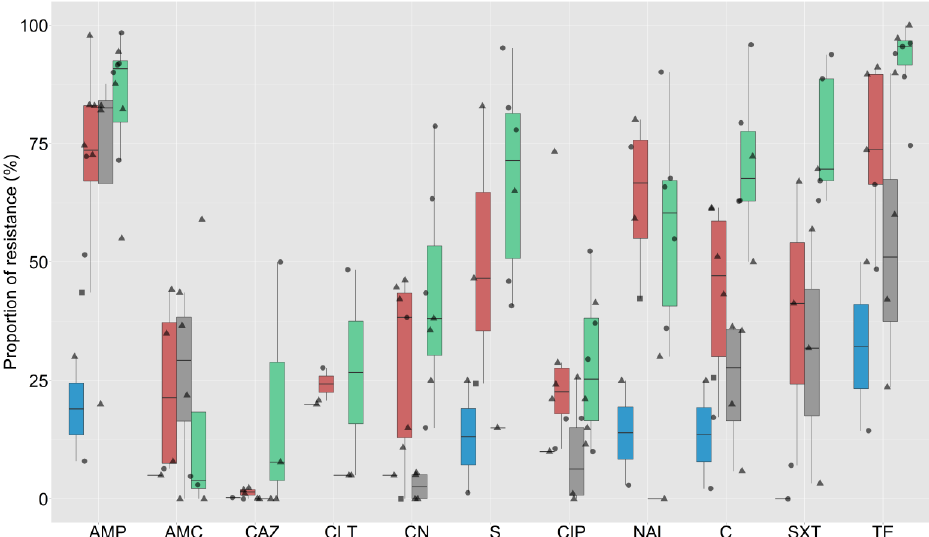
Figure 1. Summary results of estimates of prevalence of antimicrobial resistance (AMR) in Escherichia coli isolates of animal origin (N = 23). Blue = aquaculture, Red = chicken, Green = pig, Grey = other species. Circle = Thailand, triangle = Vietnam, square = Indonesia. Key: AMP = ampicillin, AMC = augmentin, CAZ = ceftazidime, CLT = cephalothin, CN = gentamicin, S = streptomycin, CIP = ciprofloxacin, NAL = nalidixic acid, C = chloramphenicol, SXT = co-trimoxazole, TE = tetracycline. Boxplots indicate median and 75% interquartile range.